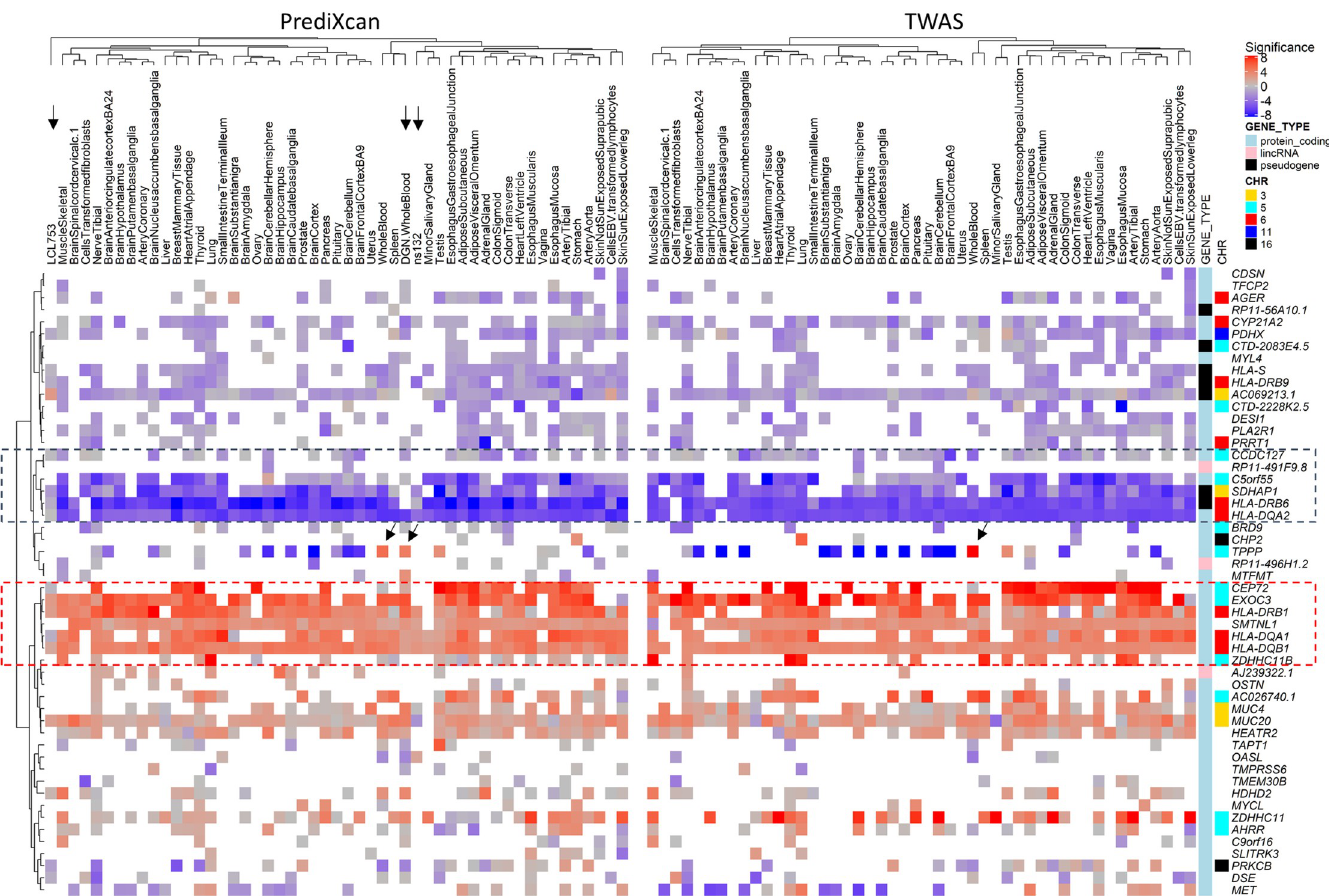
Fig 2. Hierarchical clustering of genes whose imputed expression are associated with CF lung disease severity. Consensus modifier genes (n = 52) were determined as p-value < 0.01 from all 4 meta-analyses of multiple tissue association testing described in methods, and the -log10(p-values) were clustered and represented as a heatmap with red-grey-blue color scale. The color represents direction of predicted expression change, with red indicates “protective”, or increased expression with increasing KNoRMA (milder lung disease), and blue, “harmful”, or increased expression with decreasing KNoRMA (more severe lung disease), and the intensity reflects the significance (p-values) of the association. White cells in heatmap indicate missing data, where the genes were not well predicted from the relevant tissues. The vertical color columns on the right indicate type of gene and chromosome near GWAS loci. The genes were clustered based on results from PrediXcan (left heatmap), and the order of the genes were kept the same for TWAS (right heatmap). Key patterns of negative and positive associations to KNoRMA across multiple tissues in the heatmap are highlighted by the dashed boxes. Arrows on top of the left heatmap identify the additional tissues over the 48 GTEx tissues common to both platforms, and arrows in the middle of the heatmaps show the results from whole blood tissues for TPPP